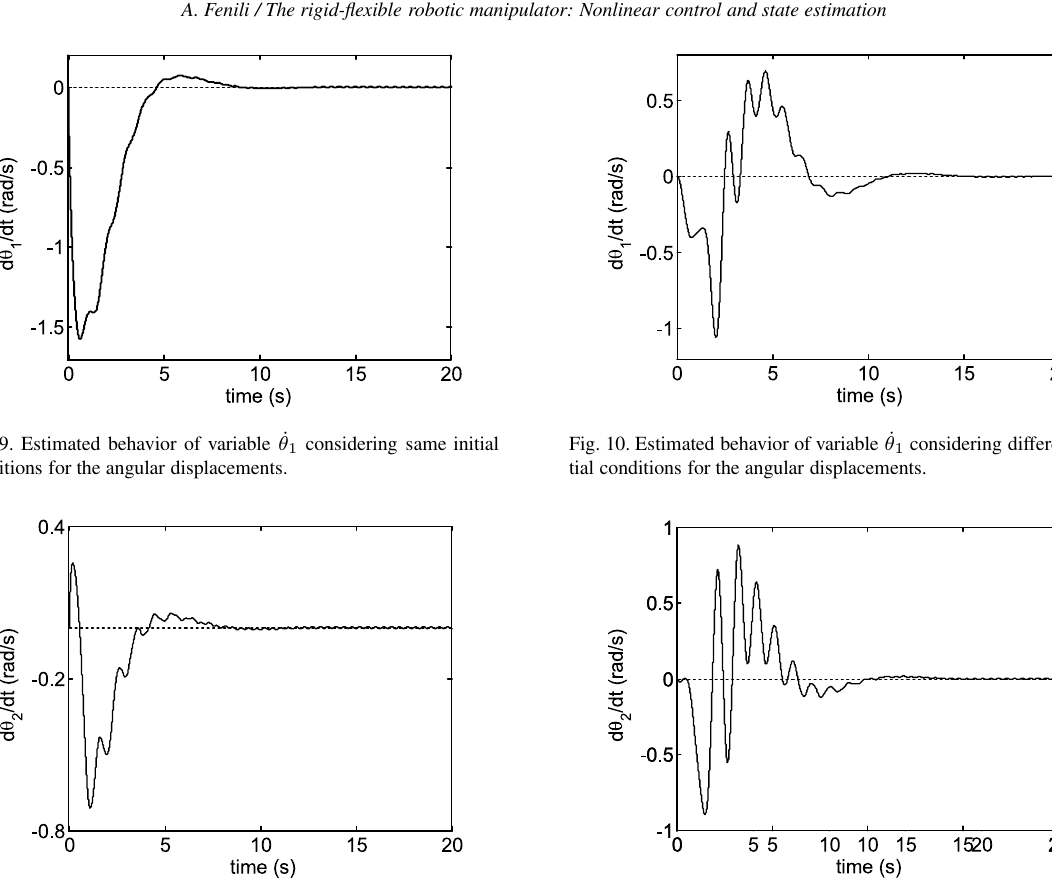
Fig. 12. Estimated behavior of variable ˙ θ 2 considering different ini- tial conditions for the angular